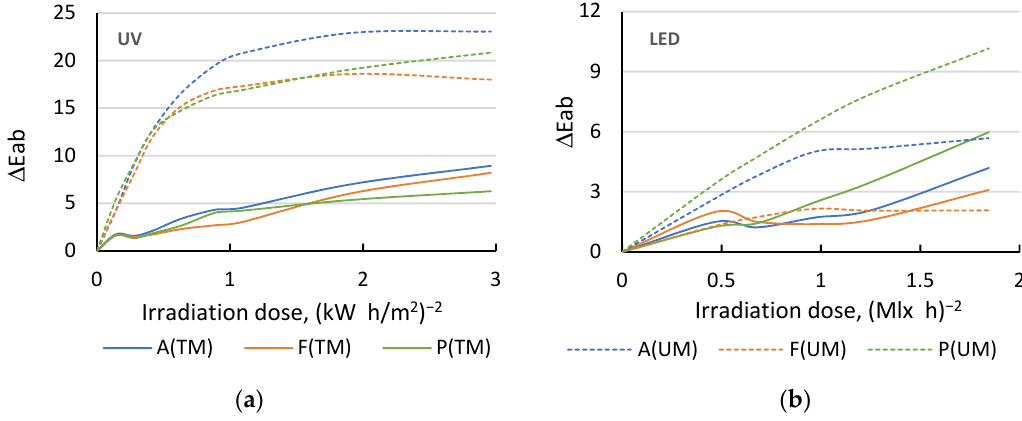
Figure 2. Discolouration of unmodified (UM) and thermally modified (TM) aspen (A), ash (F), and pine (P) wood due to exposure to UV radiation ( a ) and LED lamps ( b ).